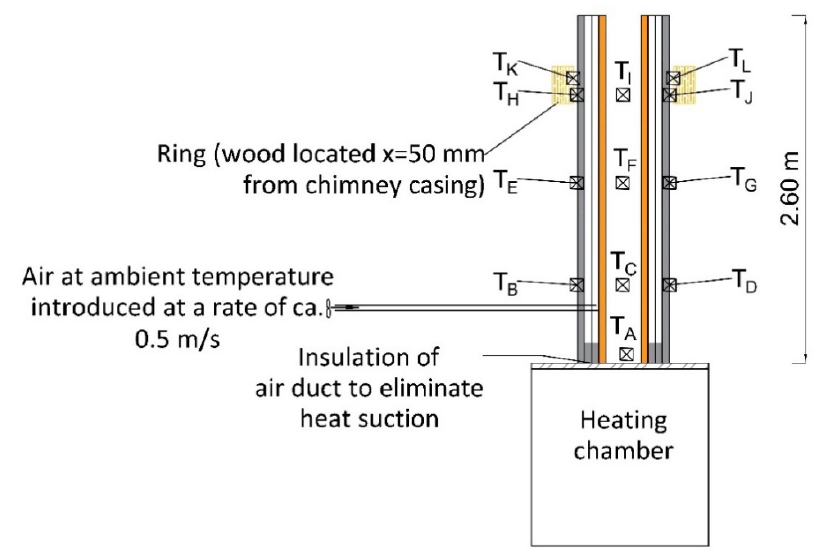
Figure 6. Diagram of the stand used for chimney fire testing.